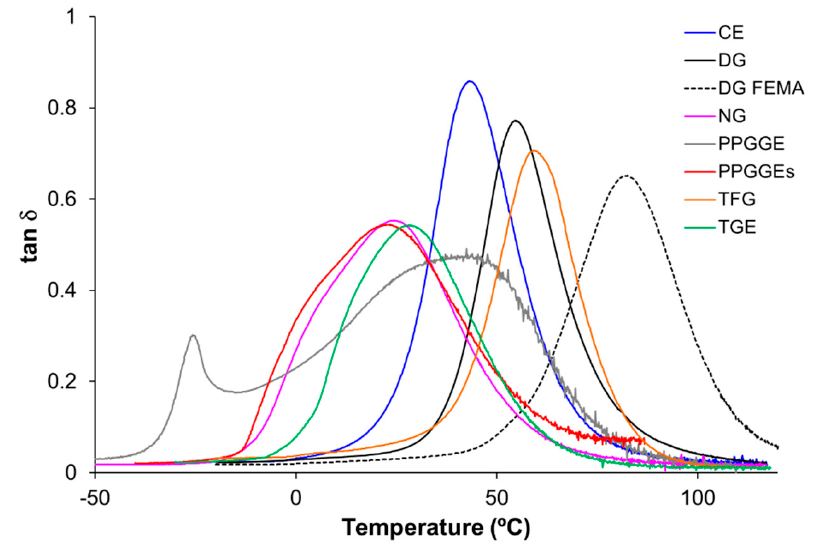
Figure 7. Tan δ curves of fully cured materials containing different epoxides. DG-FEMA formulation is the basic formulation in which PEGMA is replaced by FEMA.